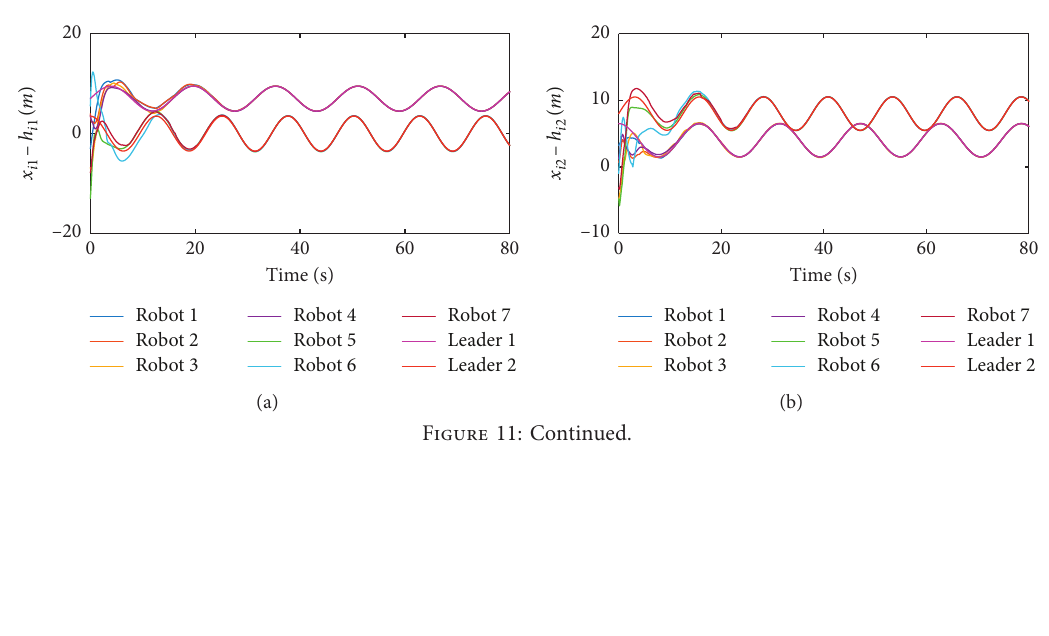
􏽥 x e i 1 (a), i 2 (b), i 1 (c), and